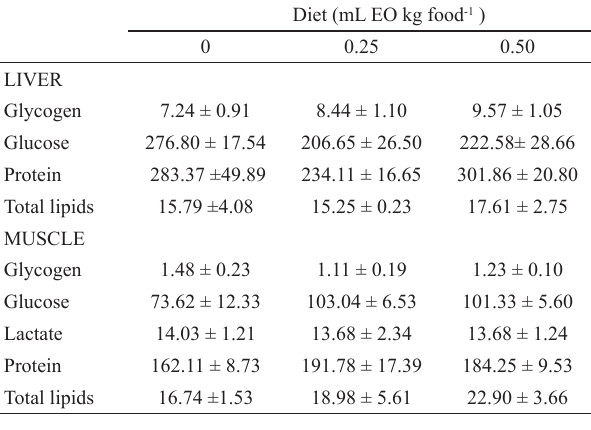
reported as mean ± ES (n=10). Significantly different from control group (P<0.05).